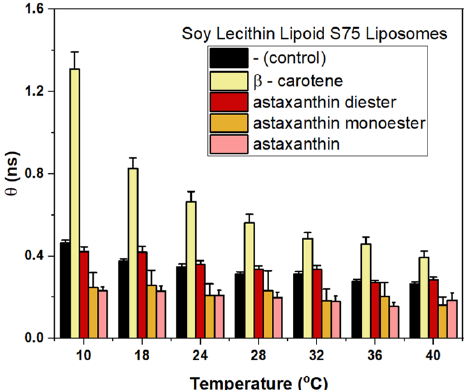
Figure 10. Effects of loading S75 liposomes with different carotenoids on membrane microviscosity as revealed by time-resolved fluorescence anisotropy of TM-BODIPY probe at 1 μM concentration. θ is rotational correlation time. Carotenoids were loaded into liposomes during their synthesis. Control values were obtained on intact liposomes without carotenoids.